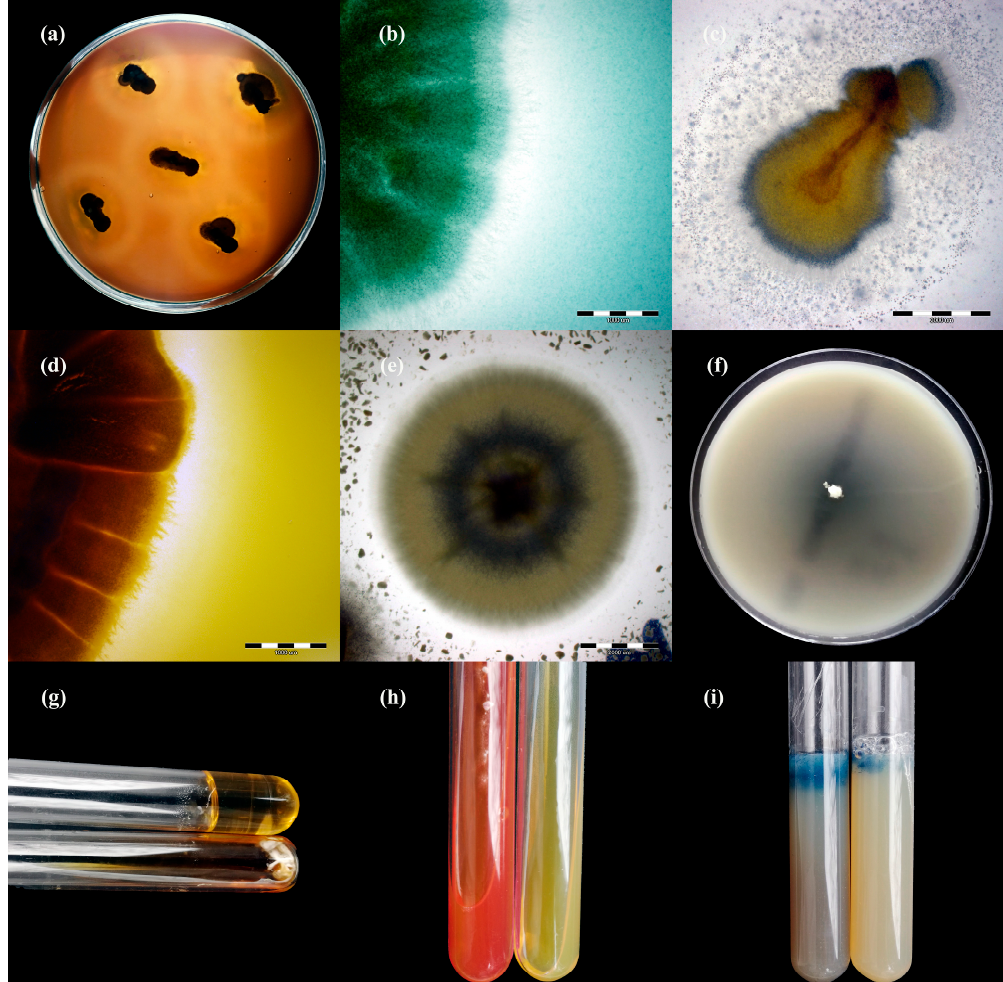
Figure 4. Enzymatic activity of Trichophyton verrucosum isolates after 21 days of incubation (picture ( a , f – i ): Nikon D3300, lens Nikon 18–105 mm VR; picture, ( c – e ): Olympus SZ61, Tokio, Japan). Legend: ( a ), haemolysis; ( b ), protease; ( c ), lipase; ( d ), phospholipase; ( e ), elastase; ( f ), DNase; ( g ), gelatinase; ( h ), urease; ( i ),